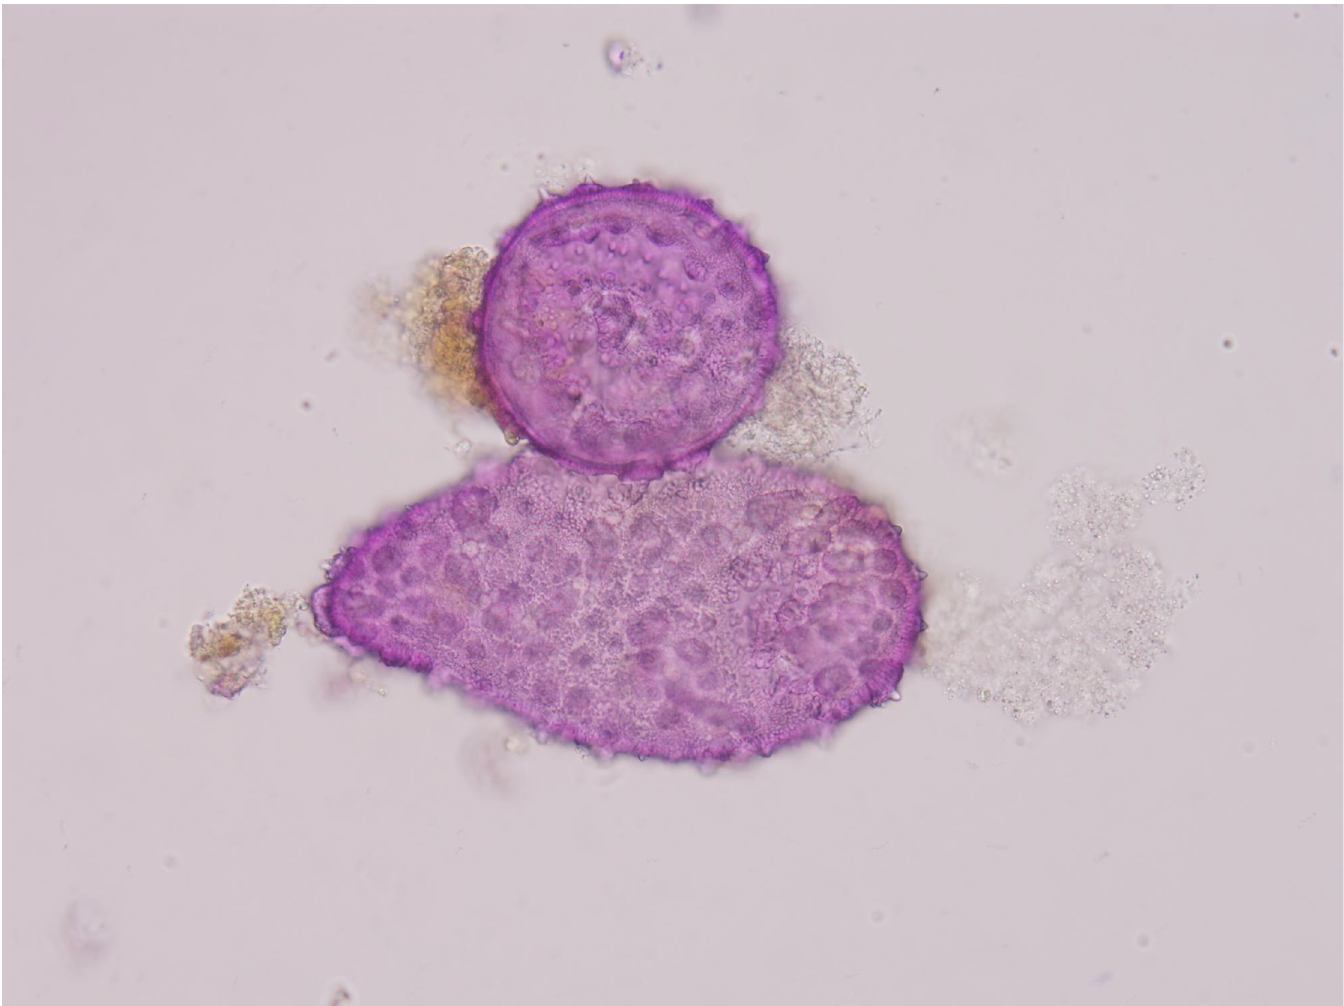
Fig 4. Abnormal meiosis behavior of the hybrid with several micronuclei of various sizes (different polyads) in telophase